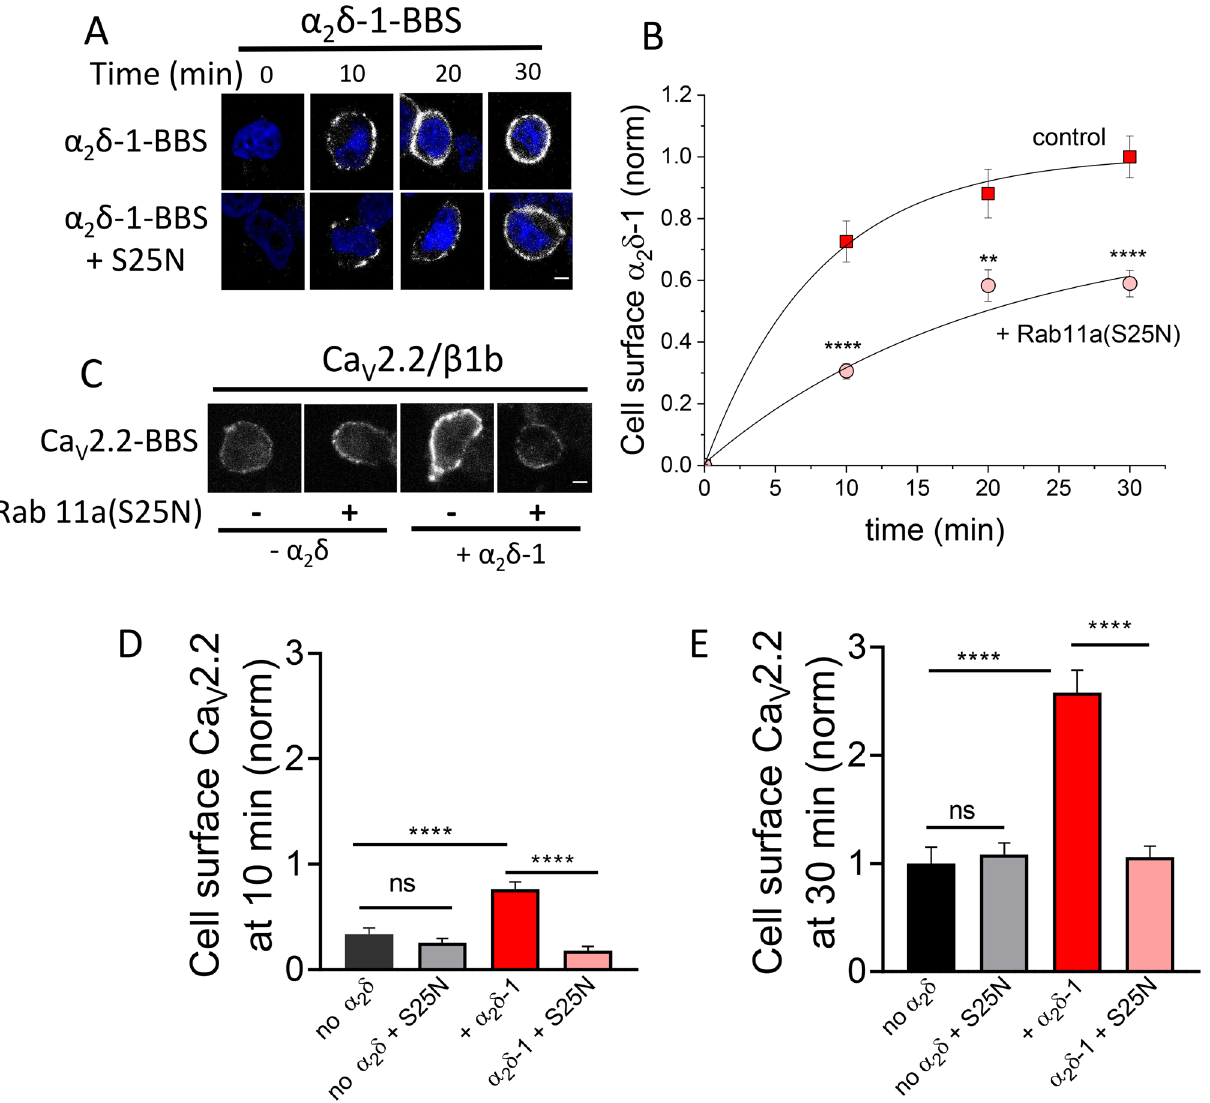
Figure 6. Rab11a(S25N) reduces net forward trafficking of α 2 δ-1 and Ca V 2.2/β1b/α 2 δ-1. ( A ) Confocal images of α 2 δ-1-BBS expressed in tsA-201 cells, alone (top row) or with Rab11a(S25N) (bottom row), at each time point of net forward trafficking assay. Cells were live-labelled with α-BTX-AF488 for 0, 10, 20, and 30 min. Nuclei staining with DAPI (blue). Scale bar = 5 μm. ( B ) Net forward α 2 δ-1-BBS trafficking, as in ( A ). Normalized mean cell-surface α 2 δ-1-BBS expressed either alone (red squares) or with Rab11a(S25N) (pink circles). Data were collected from 3 transfections with approximately 30 to 50 cells analysed per time point in each experiment. Individual experiments were normalized to the α 2 δ-1-BBS 30 min time point, before being pooled together. Data were fitted to a single exponential association, with a time constant, τ = 8.09 min for α 2 δ-1 control and 19.45 min for α 2 δ-1 + Rab11a(S25N). Statistical significance was determined using Student’s t test to compare mean fluorescence values between conditions at each time point, **** P < 0.0001; **, P = 0.0018. ( C ) Confocal images of cell-surface Ca V 2.2-BBS expressed in N2a cells with β1b either alone or with α 2 δ-1, in the absence or presence of Rab11a(S25N) after 30 min of net forward trafficking assay. Scale bar = 5 μm. ( D,E ) Normalized mean cell-surface Ca V 2.2-BBS expressed in N2a cells with β1b and: no α 2 δ (black), no α 2 δ + Rab11a(S25N) (grey), + α 2 δ-1 (red) and + α 2 δ-1 + Rab11a(S25N) (pink). Cells were live-labelled with α-BTX-AF488 for 10 min ( D ) or 30 min ( E ). Fluorescence intensity per cell was normalized to mean Ca V 2.2/β1b controls at 30 min before being pooled from 3 separate experiments and plotted as mean fluorescence ± SEM. For ( D ) no α 2 δ (black, n = 105 cells), no α 2 δ + Rab11a(S25N) (grey, n = 98 cells), + α 2 δ-1 (red, n = 123 cells) and + α 2 δ-1 + Rab11a(S25N) (pink, n = 112 cells). Statistical significances were determined: using one-way ANOVA (F = 23.12, P < 0.0001) and Sidak’s post hoc tests (** ** P < 0.0001; ns, P = 0.672). For ( E ) no α 2 δ (black, n = 105 cells), no α 2 δ + Rab11a(S25N) (grey, n = 104 cells), + α 2 δ-1 (red, n = 132 cells) and + α 2 δ-1 + Rab11a(S25N) (pink, n = 118 cells). Statistical significances were determined: using one-way ANOVA (F = 27.24, P < 0.0001) and Sidak’s post hoc tests (** ** P < 0.0001, ns, P =